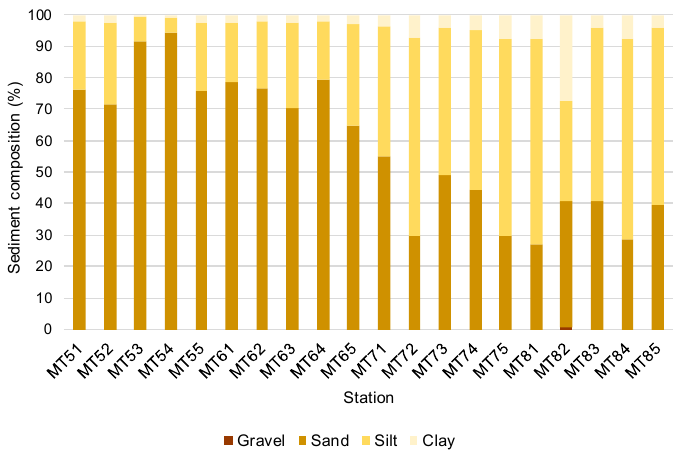
Figure 3. Sediments composition at the stations sampled at the Potiguar Basin Slope.